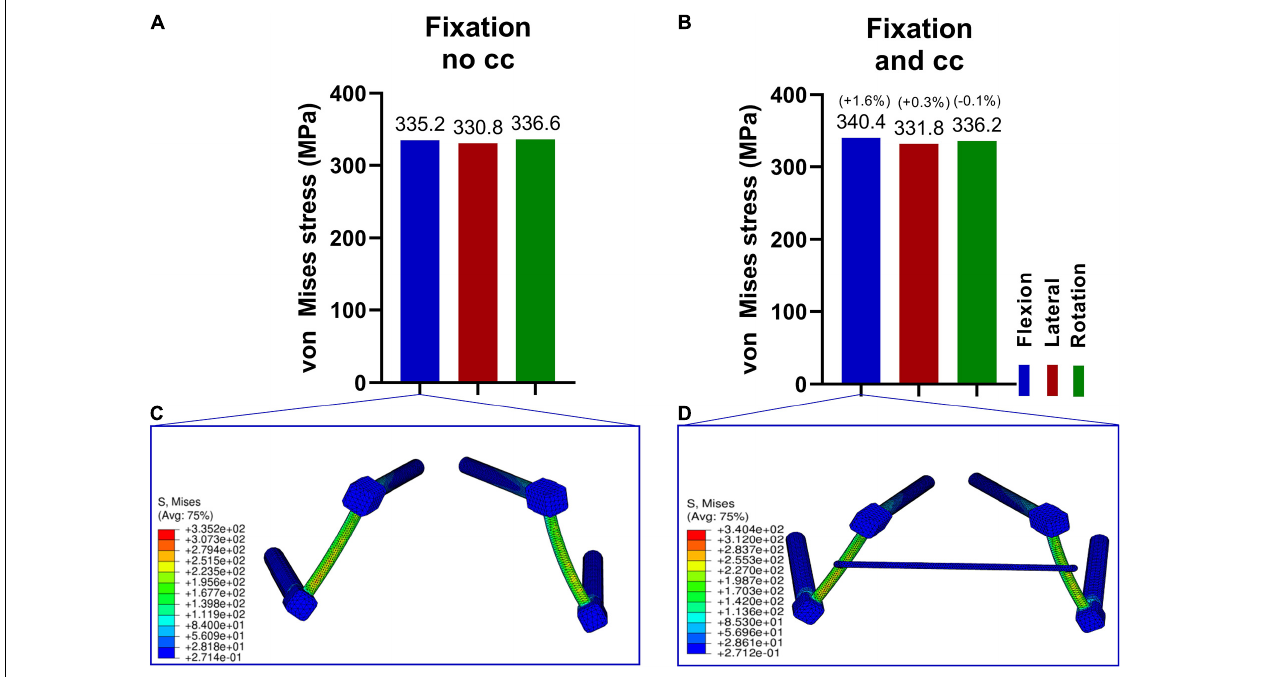
FIGURE 5 | Maximum von Mises stresses in the fixation device in three loading conditions (A,B) and corresponding stress distribution exemplarily depicted in the F/E situation (C,D) . The stresses in the fixation without cross connector (A,C) and with cross connector (B,D) are similar for all loading